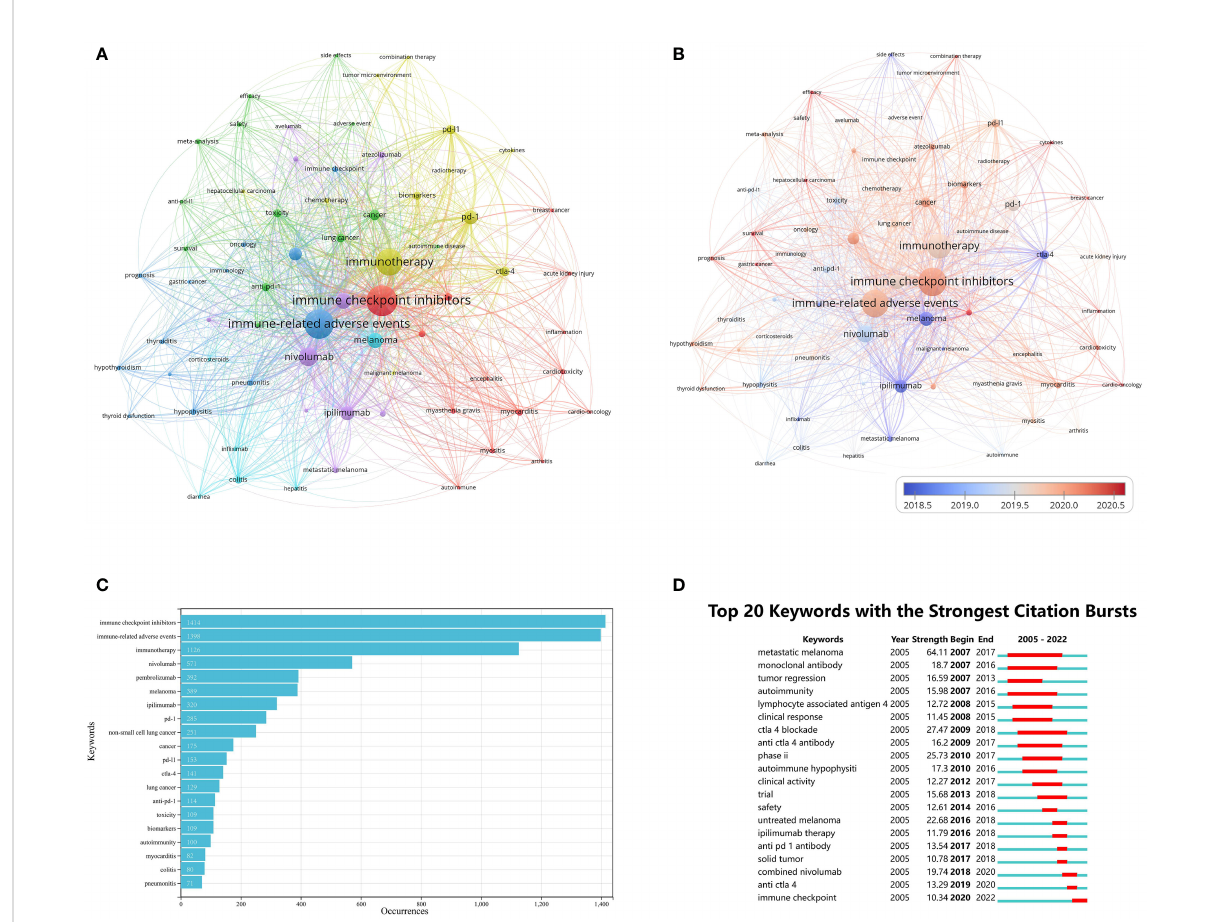
FIGURE 5 Research hotspots on irAEs (A) keyword co-occurrence network of authors; (B) time-overlapping co-occurrence analysis network of author keywords; (C) a list of the 20 most frequently used keywords; (D) the 20 keywords with the strongest citation